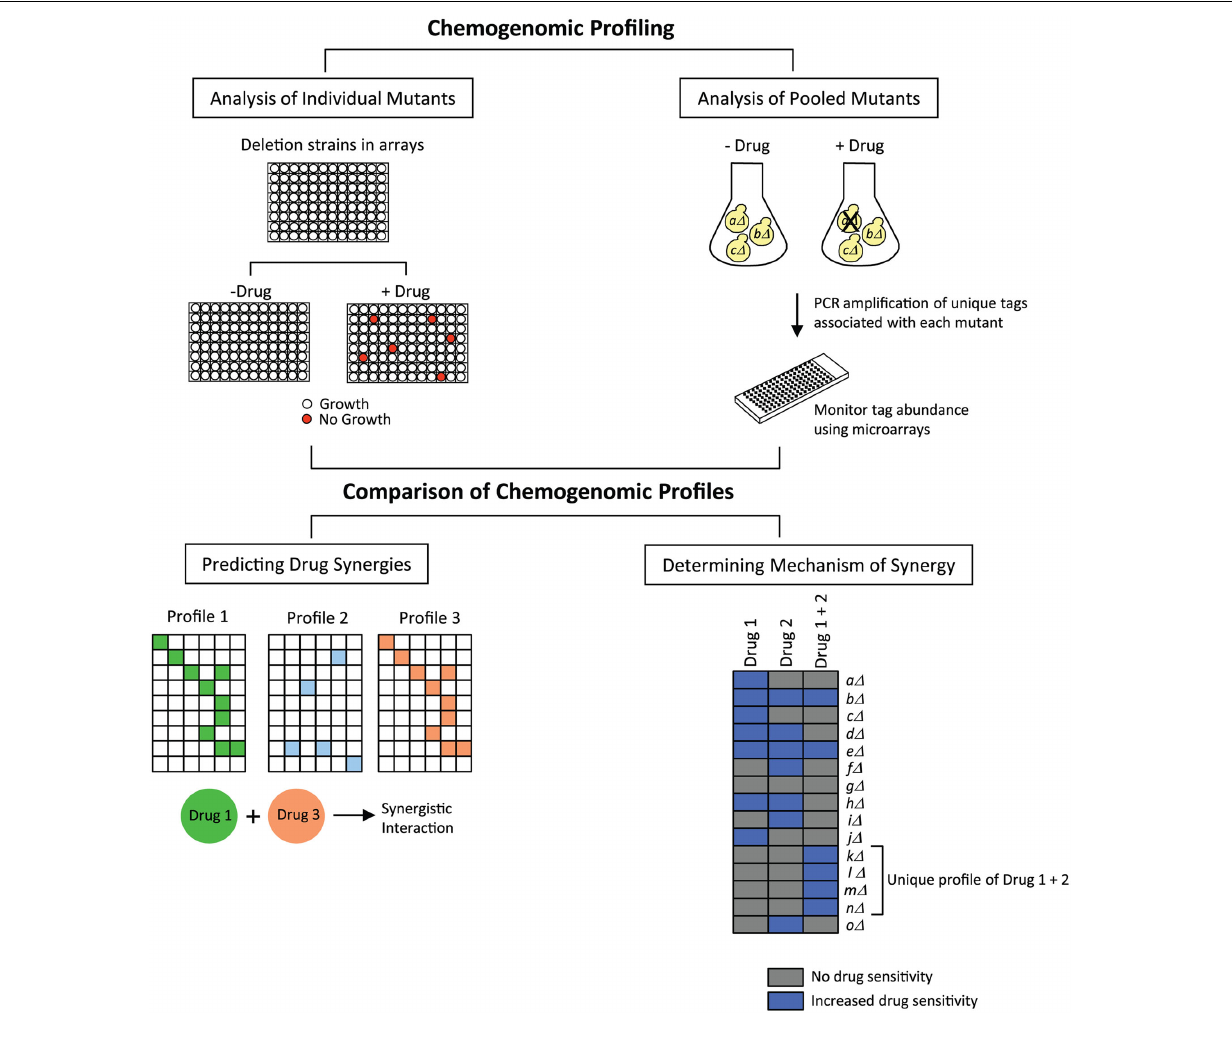
FIGURE 1 | Predicting drug synergies and determining synergy mechanisms. Chemogenomic profiling is conducted by screening drugs against collections of yeast deletion mutants. For analyzing individual mutants, the collection is arrayed in microplates, and the growth of each strain is examined in the presence or absence of the drug. For analyzing pooled mutants, the collection is grown in a single culture, with or without drug, and growth is measured by monitoring the abundance of unique tags